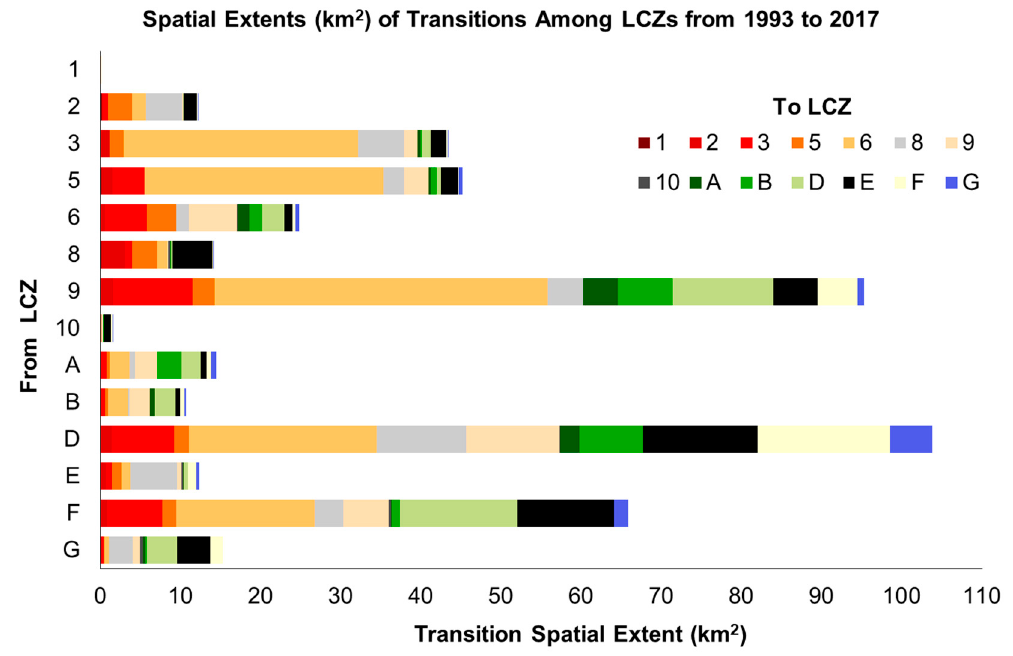
Figure 5. Major transitions among Salt Lake Valley’s Local Climate Zones from 1993 to 2017.